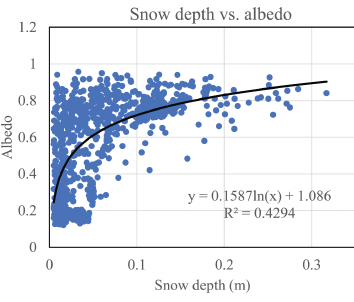
Figure B6. Scatterplot of snow depth and albedo (Yakou station, 2014–2017).